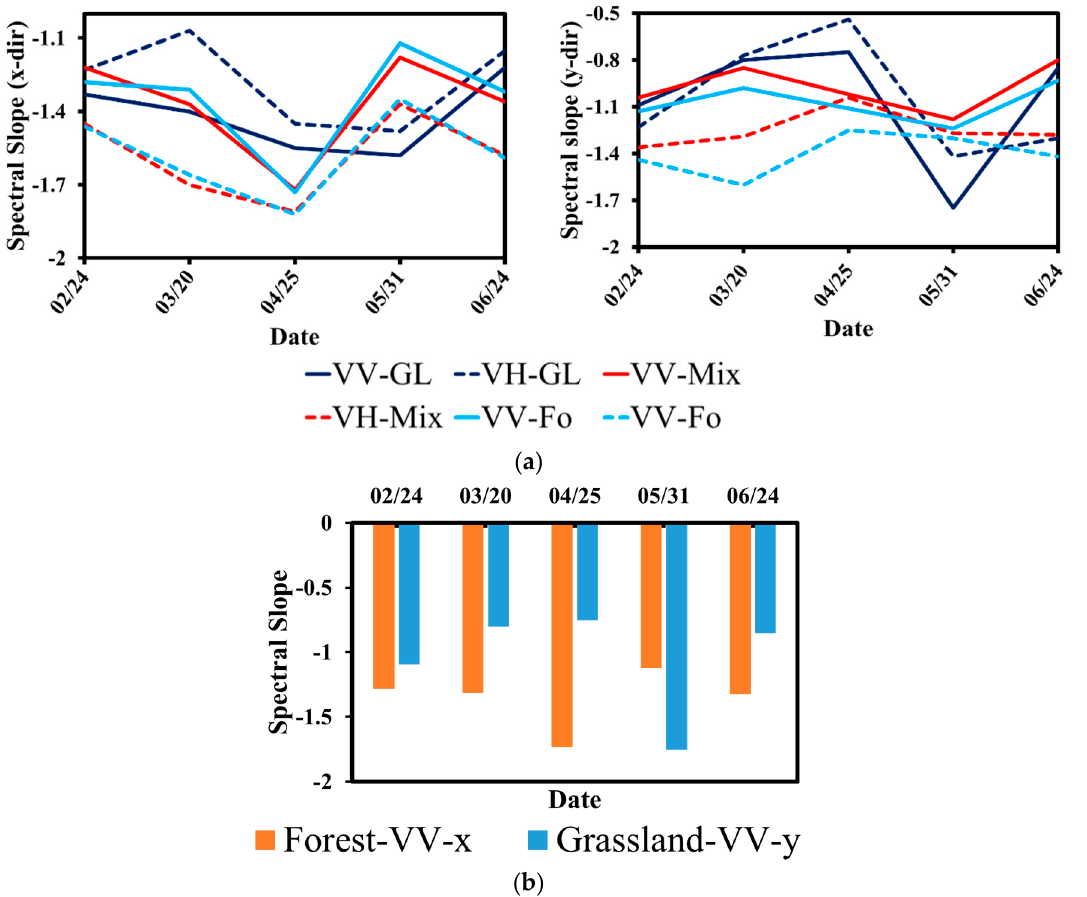
Figure 15. ( a ) Temporal evolution of directional spectral slopes of VV and VH BSC over grassland (GL,180–900 m), mixed (Mix) and forest (FO, 250–1500 m) in Grand Mesa in 2017 (areas A, B and C, Figure 3). ( b ) Synthesis of contrasting scaling between forest (orange, area C) and grassland (blue, are A) in part ( a ).